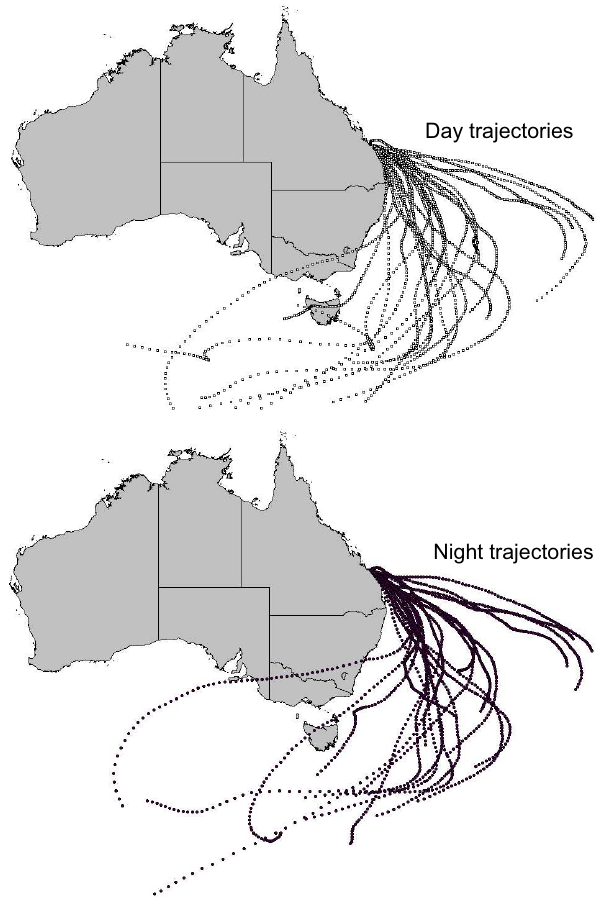
Fig. 3. HYSPLIT 96-hour back trajectories for air masses arriving at Agnes Water at an altitude of 100 m on each day (12:00 local time) and night (02:00 local time) of the campaign. Note that there was no significant between these trajectories and the trajectories of air masses arriving at altitudes of 10m and